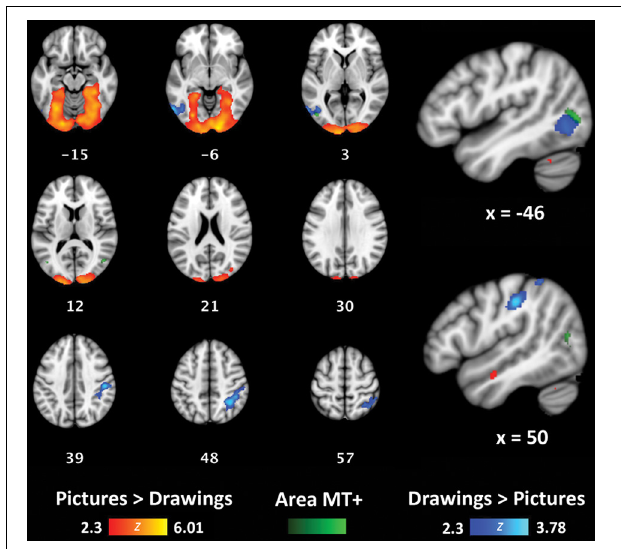
FIGURE 5 | Whole-brain analyses contrasting Picture/Picture(Different) (red/yellow) and Drawing/Drawing(Different) (blue/light blue) trials. The group-level location of visual-motion-preferring voxels is shown in green. Coordinates reported in MNI standardized space.